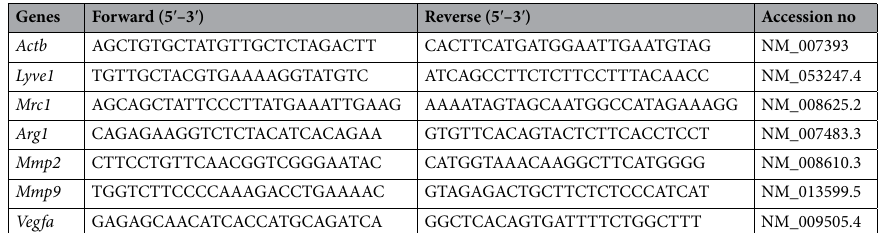
Table 1. Primer sequences. Accession numbers are available at https:// www. ncbi. nlm. nih. gov/ nucle